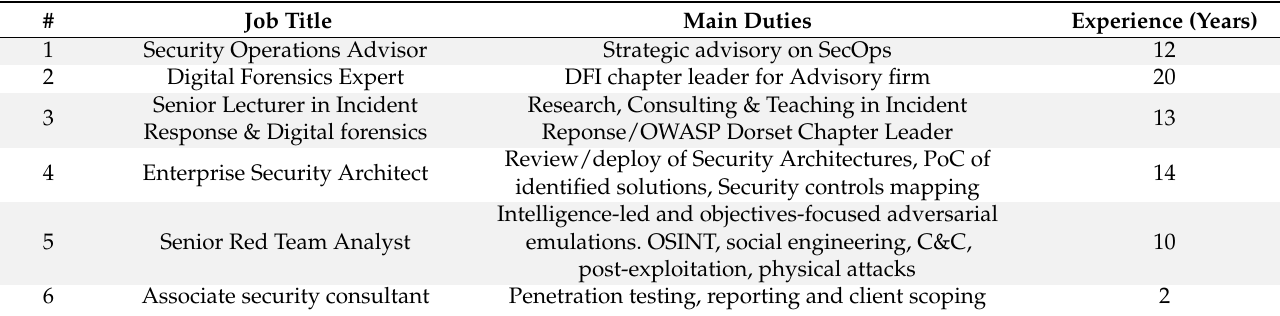
Table 7. Background information of experts interviewed for gathering the cost values α i , κ i